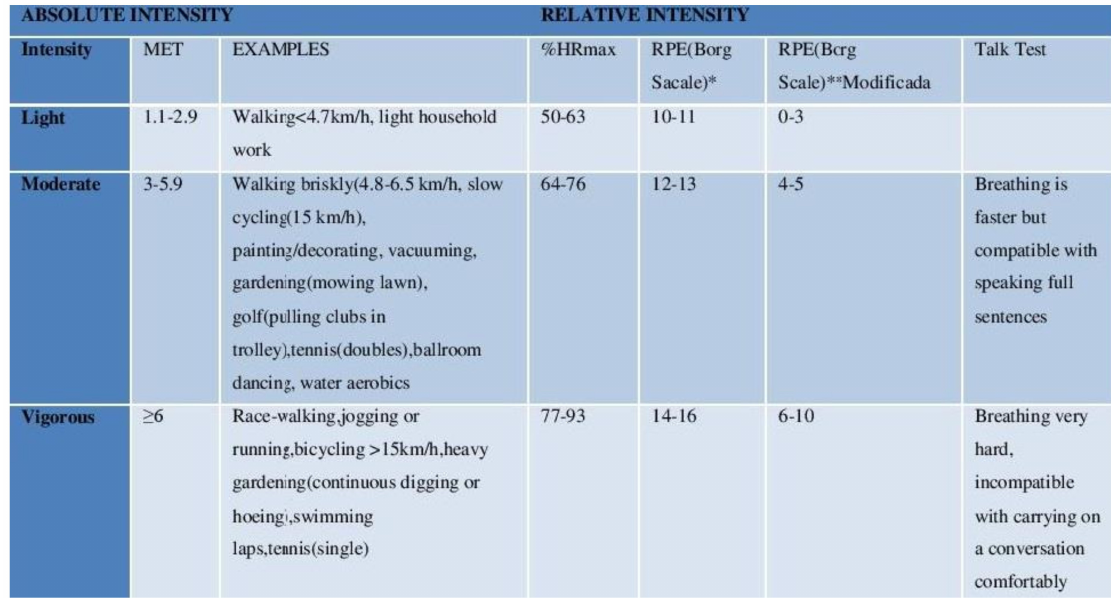
Figure 1. Classification of intensity of physical activity. Examples of absolute and relative levels of intensity. Source: Modified from Howley [29]. MET= metabolic equivalent); RPE = rating of perceived exertion) (*20 value Borg score) (**10 value Borg score). % HRmax = percentage of measured or estimated maximum heart rate (220-age). Heart rate (HR): <76% Maximum heart rate